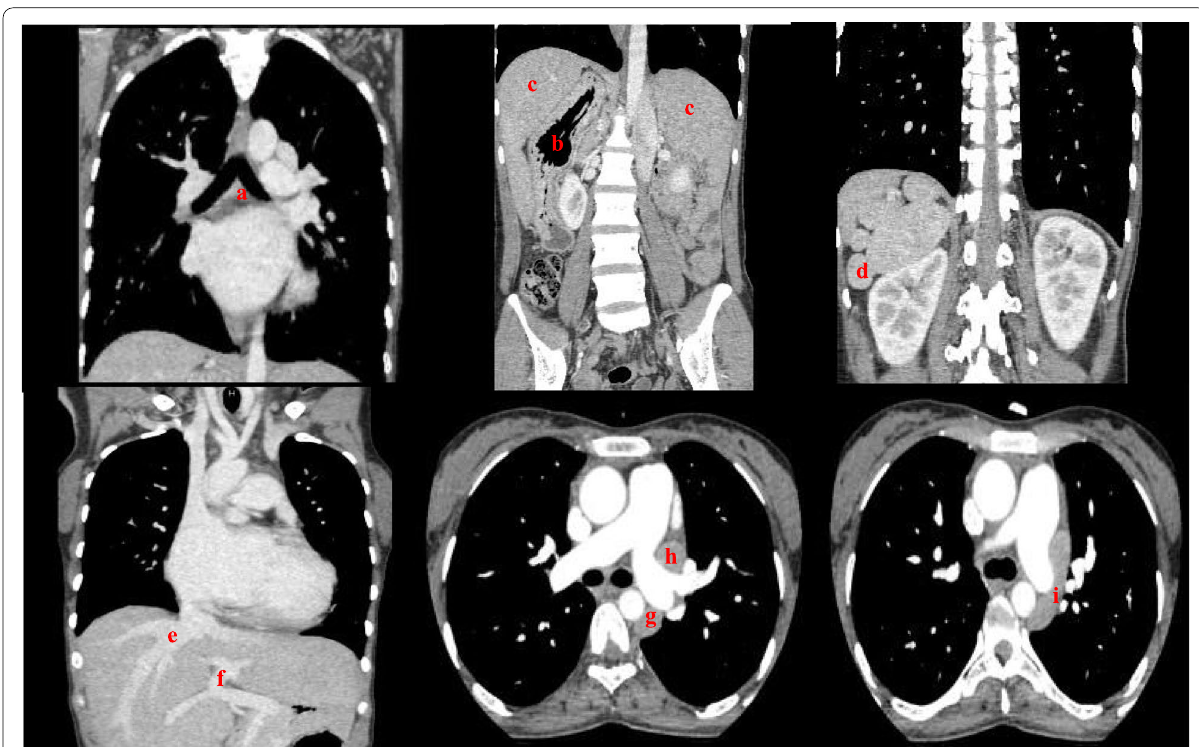
Fig. 2 Cardiac CECT demonstrating the following: ( a ) bilateral hyparterial bronchi, b right-sided gastrium, ( c ) transverse liver, ( d ) multiple spleniculi, ( e ) hepatic vein draining into right side of common atrium, ( f ) infra-hepatic interrupted IVC, ( g ) hemizygos continuation of IVC, ( h ) PLSVC, ( i ) confluence of hemiazygos into